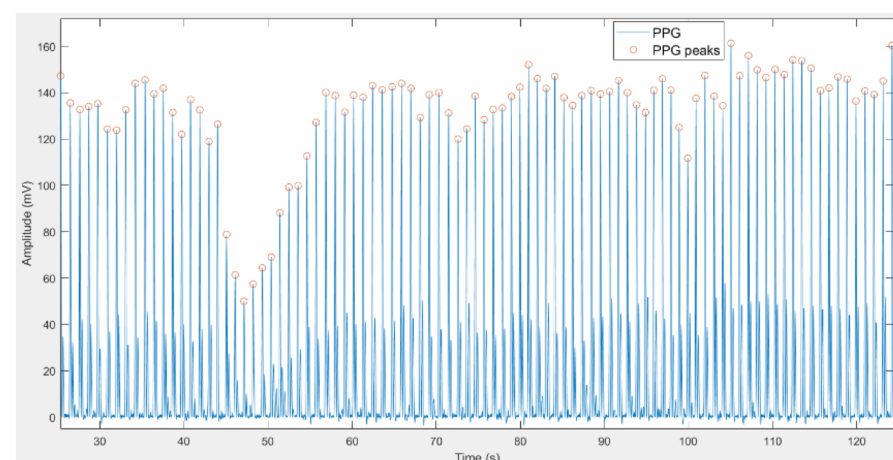
Figure 11. S-peaks detection in signals from the SHIMMER